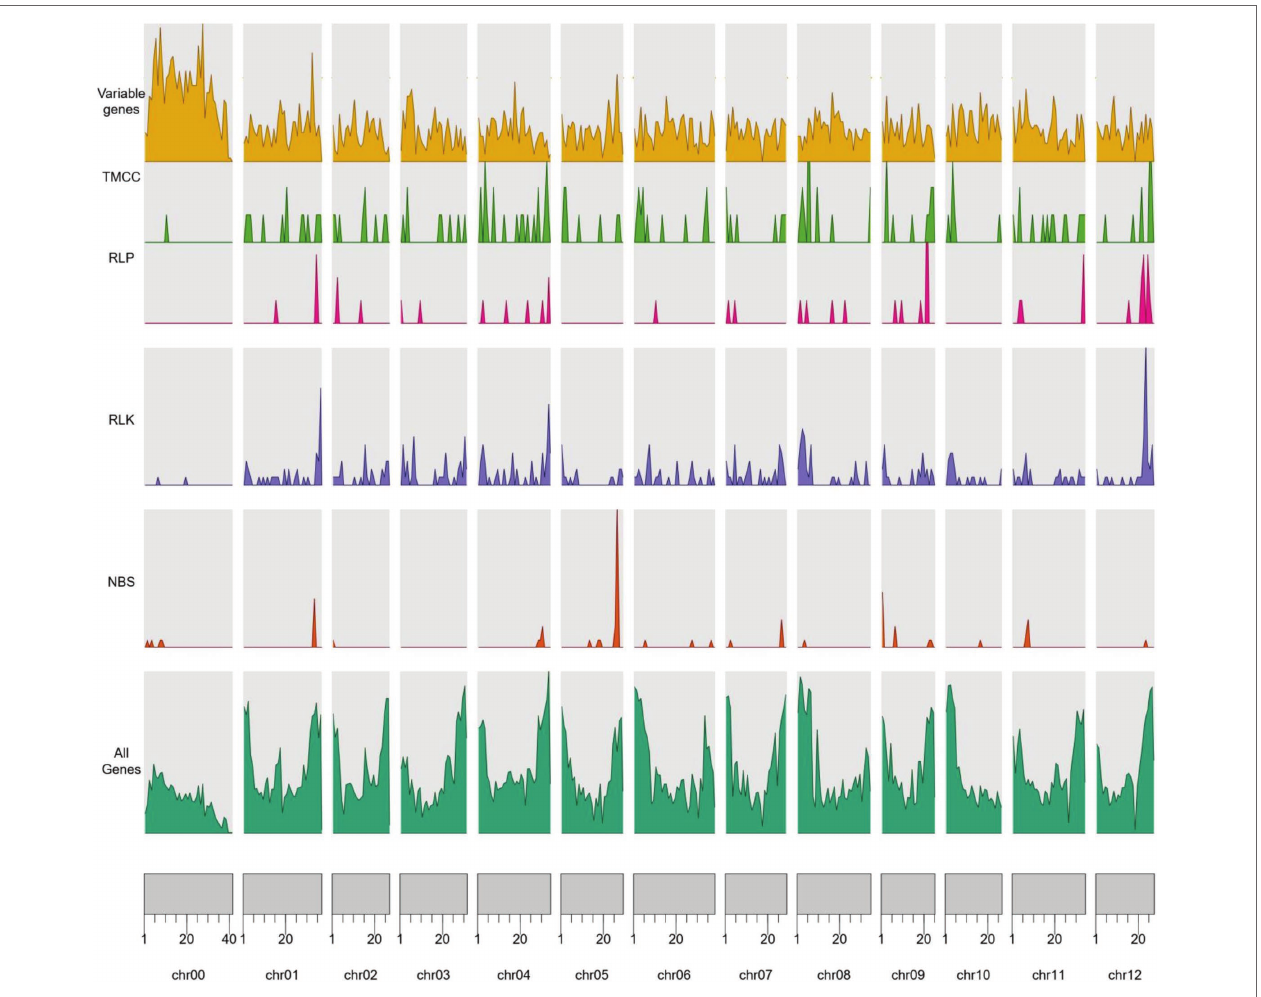
FIGURE 3 | The distribution of variable genes and nucleotide binding site (NBS), receptor-like protein (RLP), receptor-like protein kinase (RLK), and transmembrane coiled-coil domain protein (TM-CC) domains across the reference genomes.